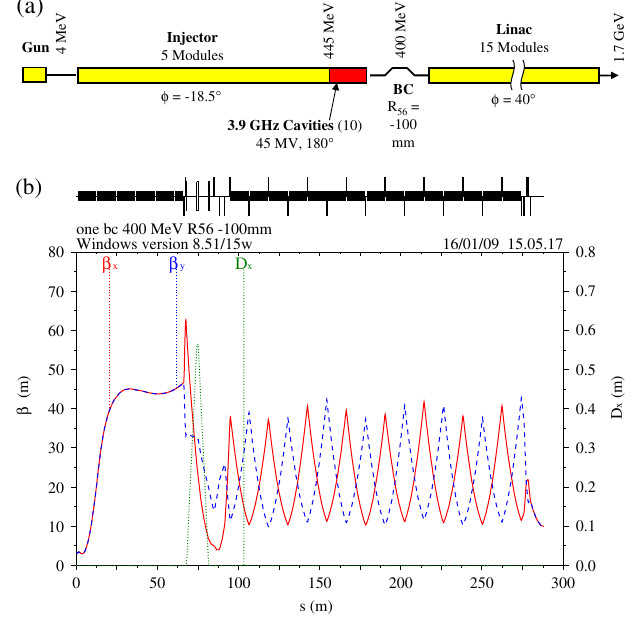
FIG. 1. Single-stage bunch compressor for WiFEL. (a) Schematic diagram. (b) Lattice